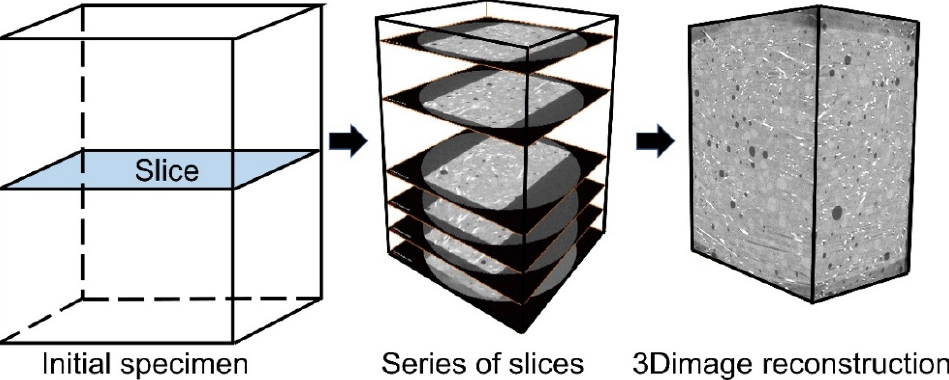
Figure 6. 3D image reconstruction of the BCSF-reinforced UHPC mix specimens using X-ray com- puted